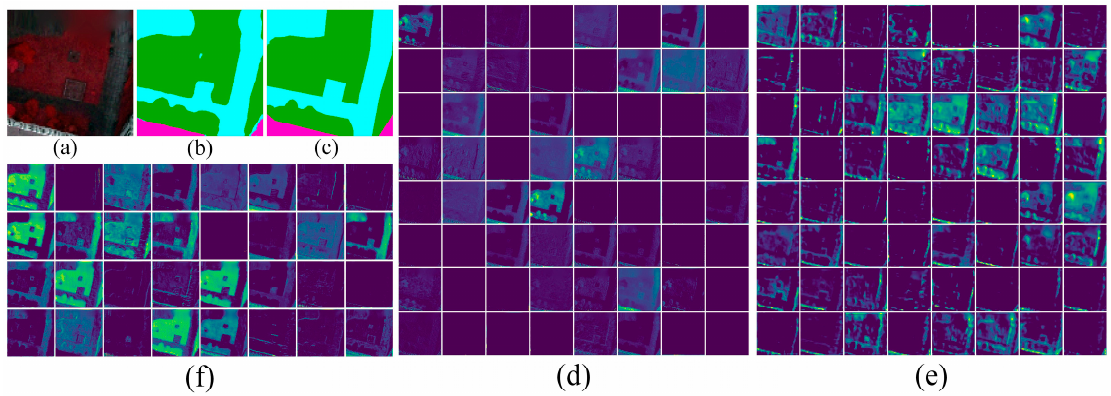
Figure 5. Features visualization. ( a ) Input coarse remote sensing images; ( b ) simulated result; ( c ) reference result; ( d ) visualization of first output features; ( e ) visualization of ninth output features; ( f ) visualization of 18th output features.